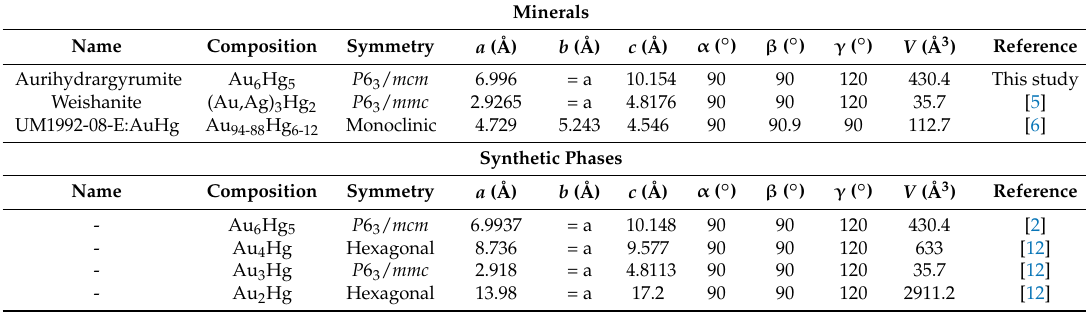
Table 3. Comparable data for minerals and synthetic phases in Au–Hg